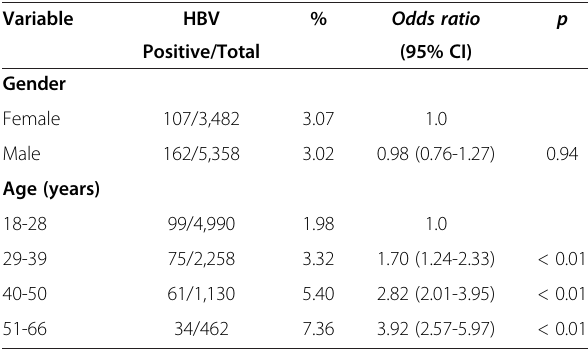
Table 1 Prevalence of hepatitis B viral infection among first-time blood donors by gender and age in Campo Grande, Brazil, 2010